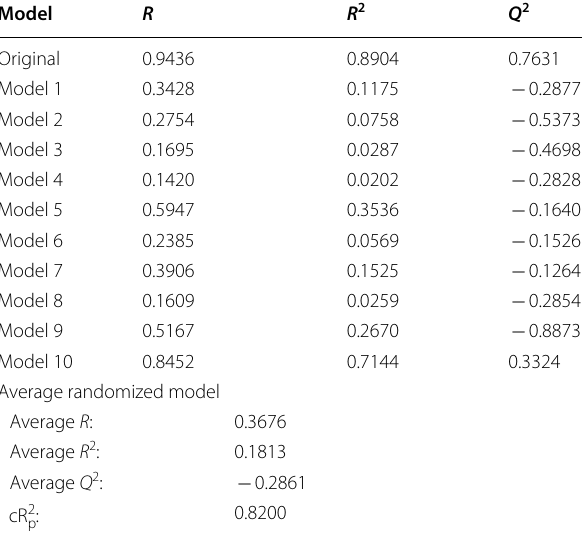
Table 4 Y-randomization